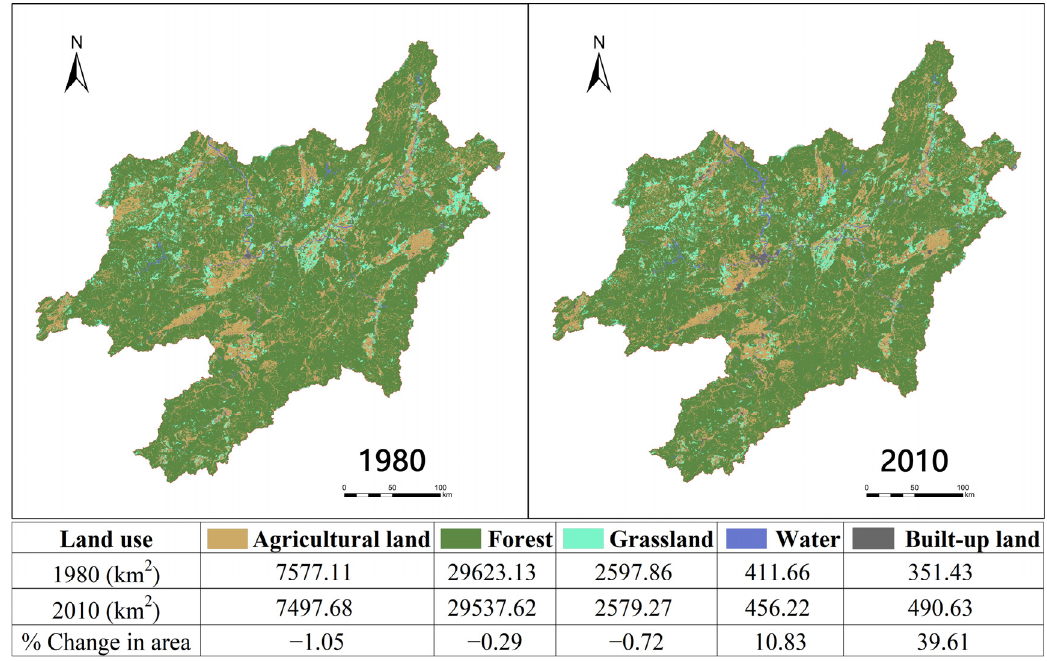
Figure 2. Land-use distribution and changes in the upper Ganjiang River basin, 1980 and 2010.